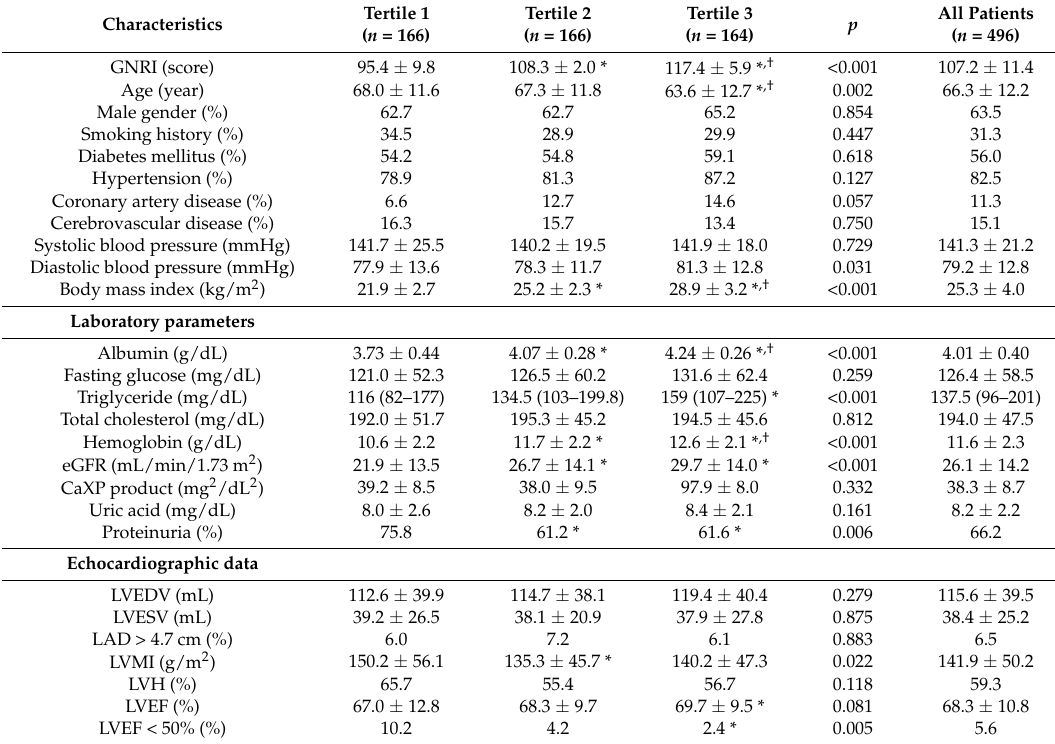
Table 1. Clinical characteristics of patients according to tertiles of GNRI.